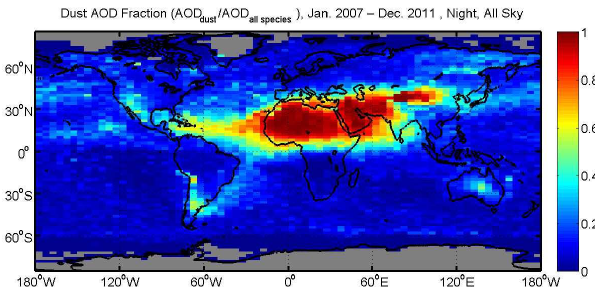
Fig. 5. Mean dust AOD fraction,